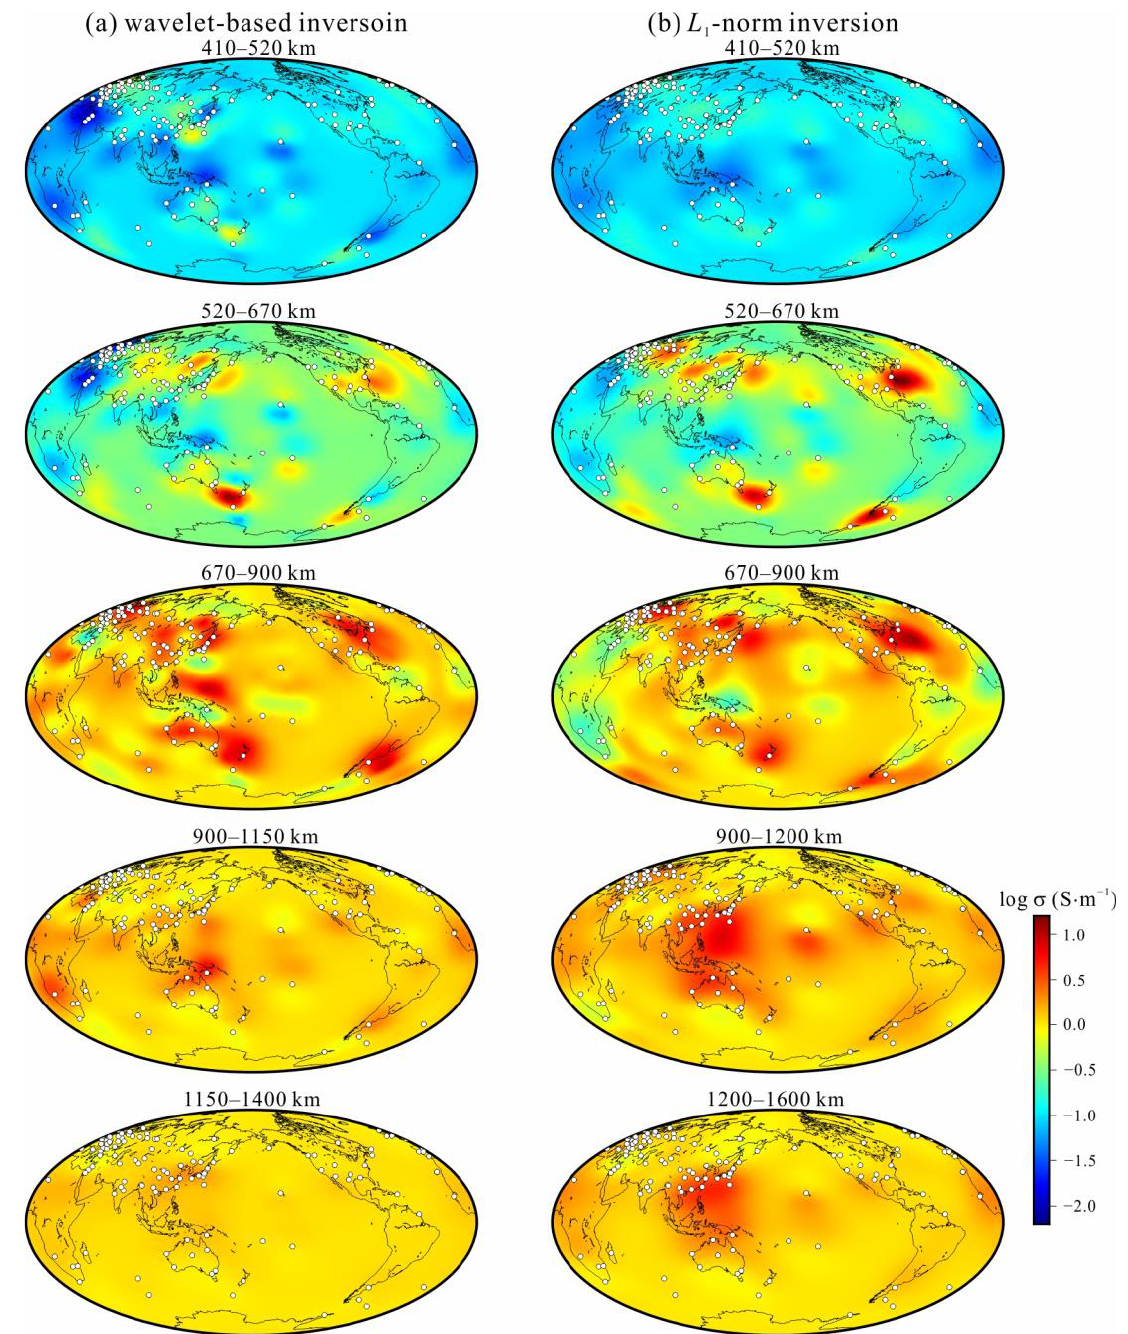
Figure 12. Inverted global electrical conductivity results of the wavelet-based ( a ) and L 1 -norm ( b ) inversions of responses for 129 observatories (white circles in figures).